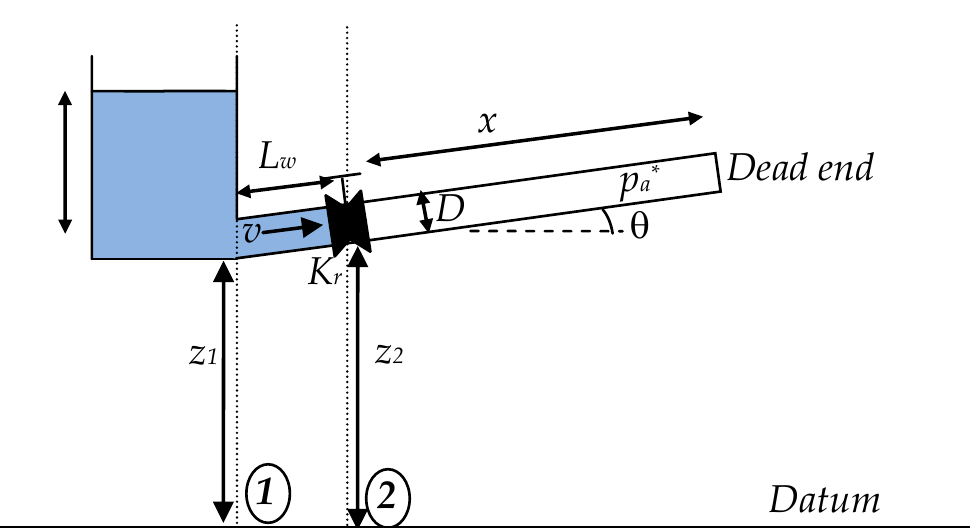
Figure 2. Schematic of a filling process in a single pipeline with an entrapped air pocket.